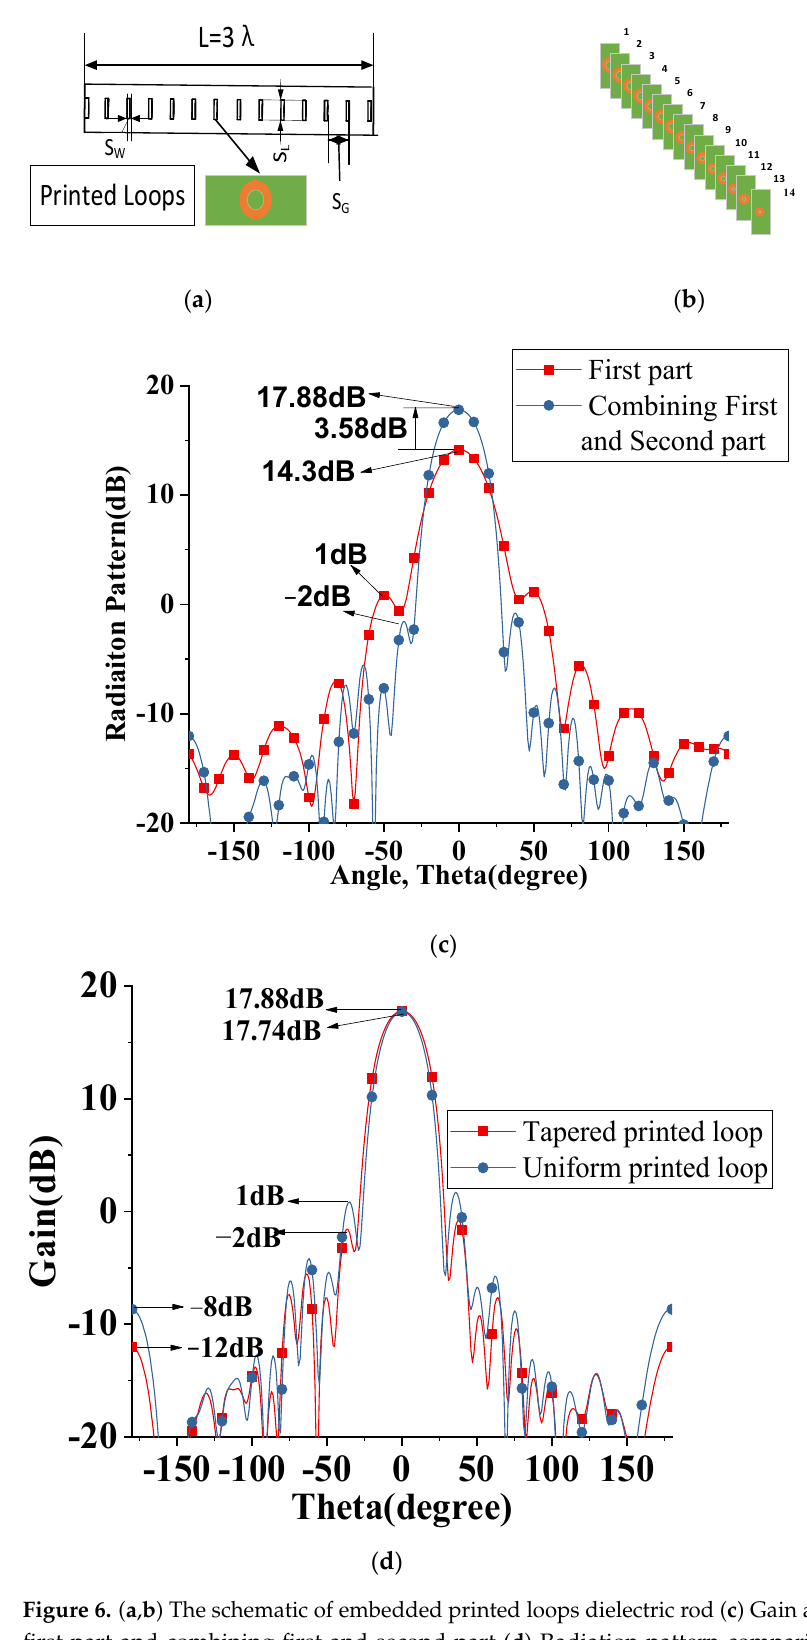
Figure 6. ( a , b ) The schematic of embedded printed loops dielectric rod ( c ) Gain and SLL comparison first part and combining first and second part ( d ) Radiation pattern comparison of tapered and uniform printed loop.